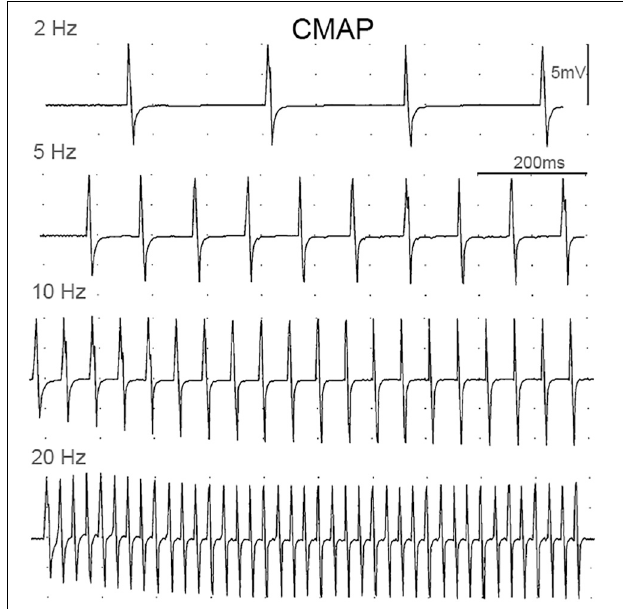
FIGURE 3 | Examples of CMAP responses at different stimulation